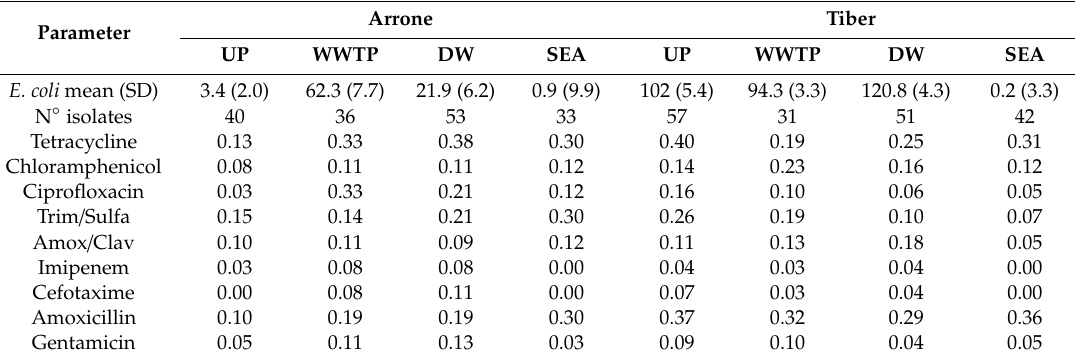
Table 1. Mean culturable Escherichia coli concentration (CFU / mL; standard deviation), number of sampled isolates, and frequency of isolates with phenotypic antibiotic resistance per sampling